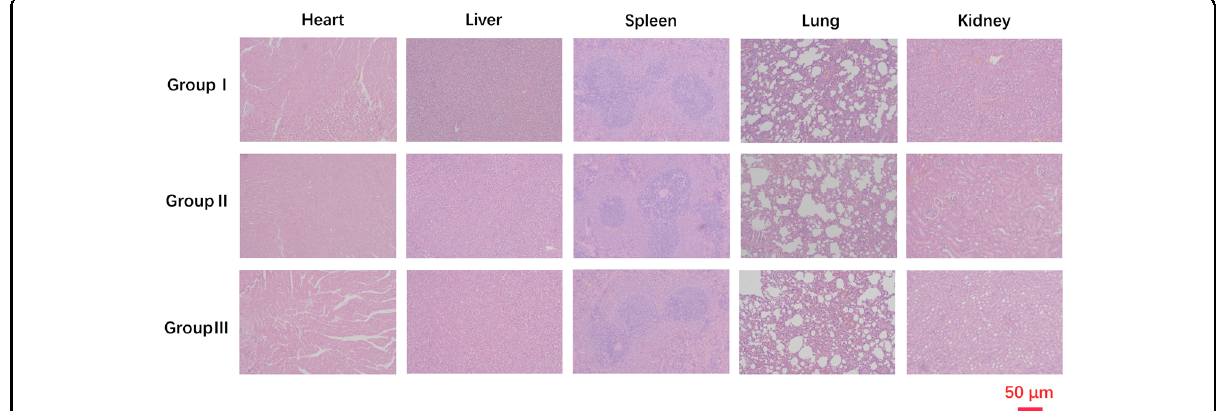
Fig. 6 In vivo biocompatibility of NC hydrogel. H&E staining of major organs (heart, liver, spleen, lung and kidney) of the rats after different treatments on Day